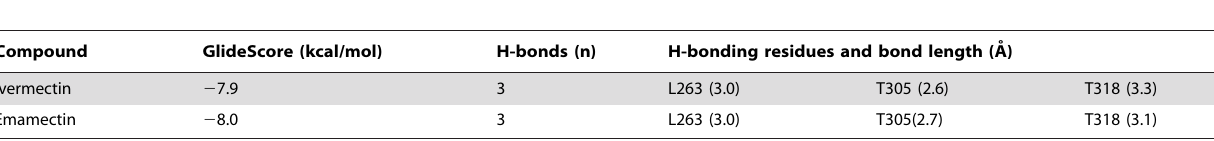
Table 1. Energy and affinity values for the best pose of ivermectin and emamectin in docking assays with CrGluCl a molecular